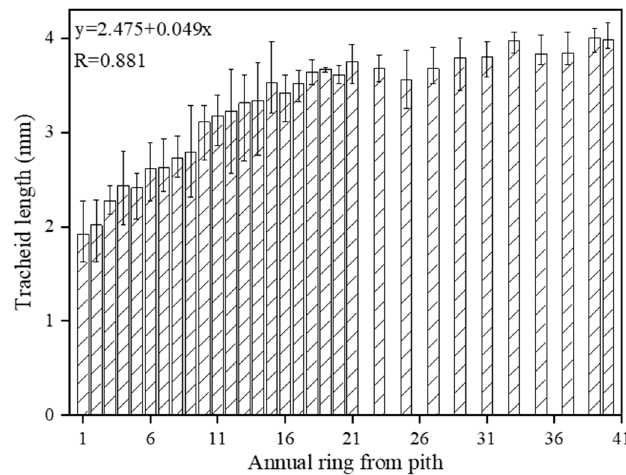
Figure 3. Radial variation in larch tracheid length. Data are averages ( ± SD) for the ring from 1 to 40.